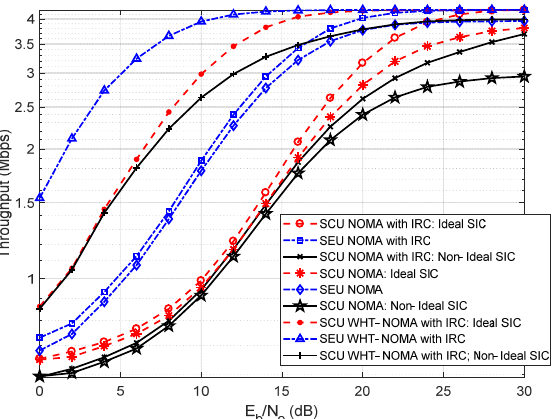
Figure 21. Throughput performance with IRC and 8-QAM modulation; NOMA vs. WHT–NOMA, power allocation: SCU = 0.2 and SEU = 0.8.